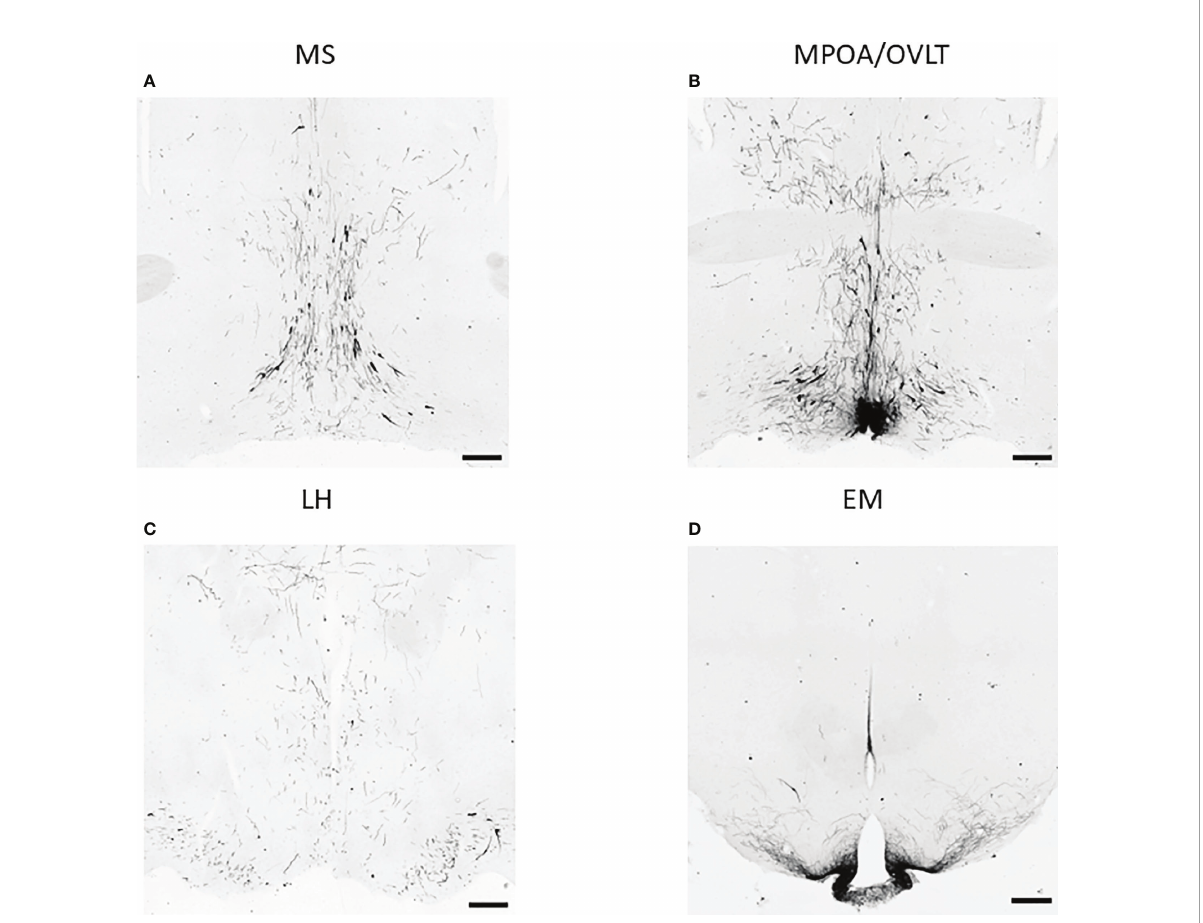
FIGURE 2 GnRH neurons and their arborization in different brain regions. Representative images of immunohistochemical labeling of GnRH neurons and their fi bers located in the medial septum (MS), medial preoptic area (MPOA) together with organum vasculosum of lamina terminalis (OVLT), lateral hypothalamus (LH), and eminentia mediana (EM) are shown in panels (A – D) respectively (scale bar: 200 µm).